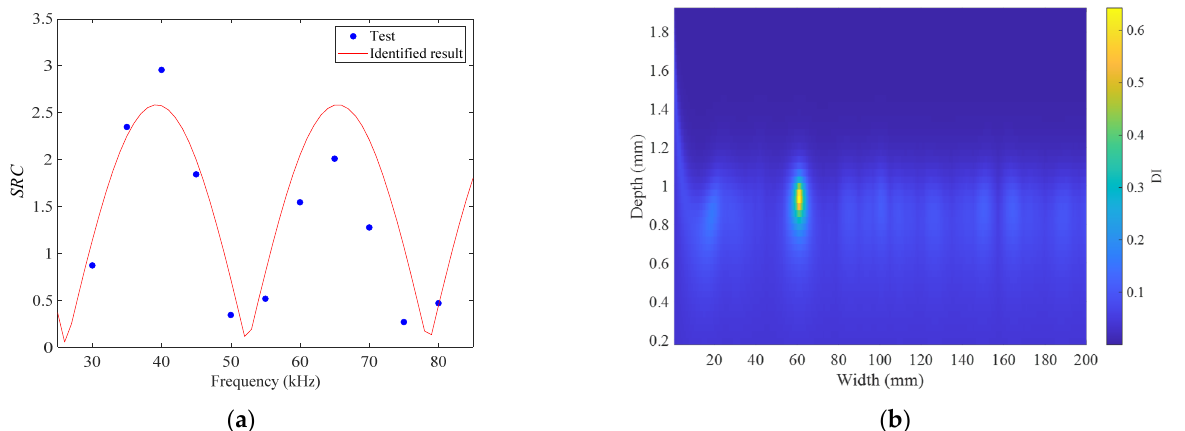
Figure 9. ( a ) Variation of the SRC with respect to the excitation frequency; ( b ) damage image for the 60 mm-wide and 1.05 mm-deep defect.